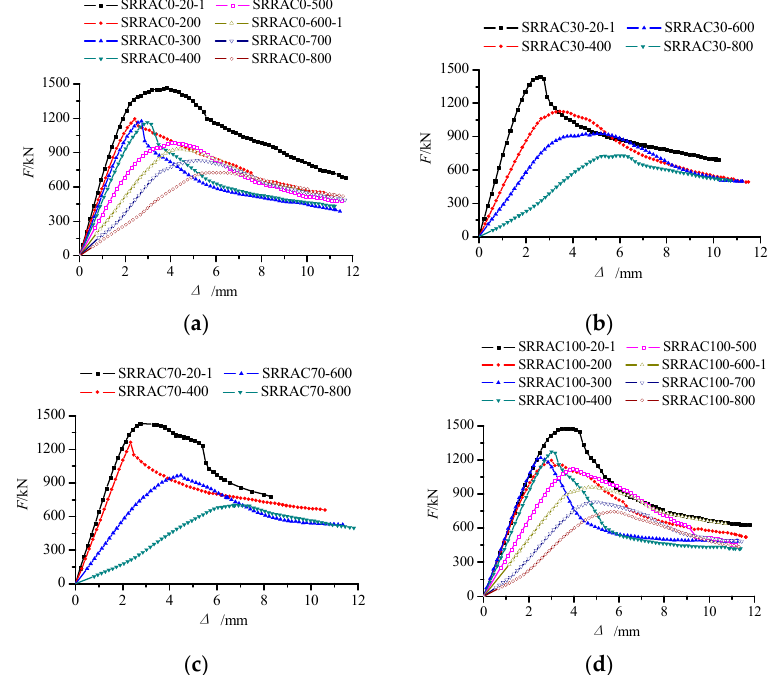
Figure 9. Load-displacement curves of SRRAC columns. ( a ) r = 0%; ( b ) r = 30%; ( c ) r = 70%; ( d ) r = 100%.